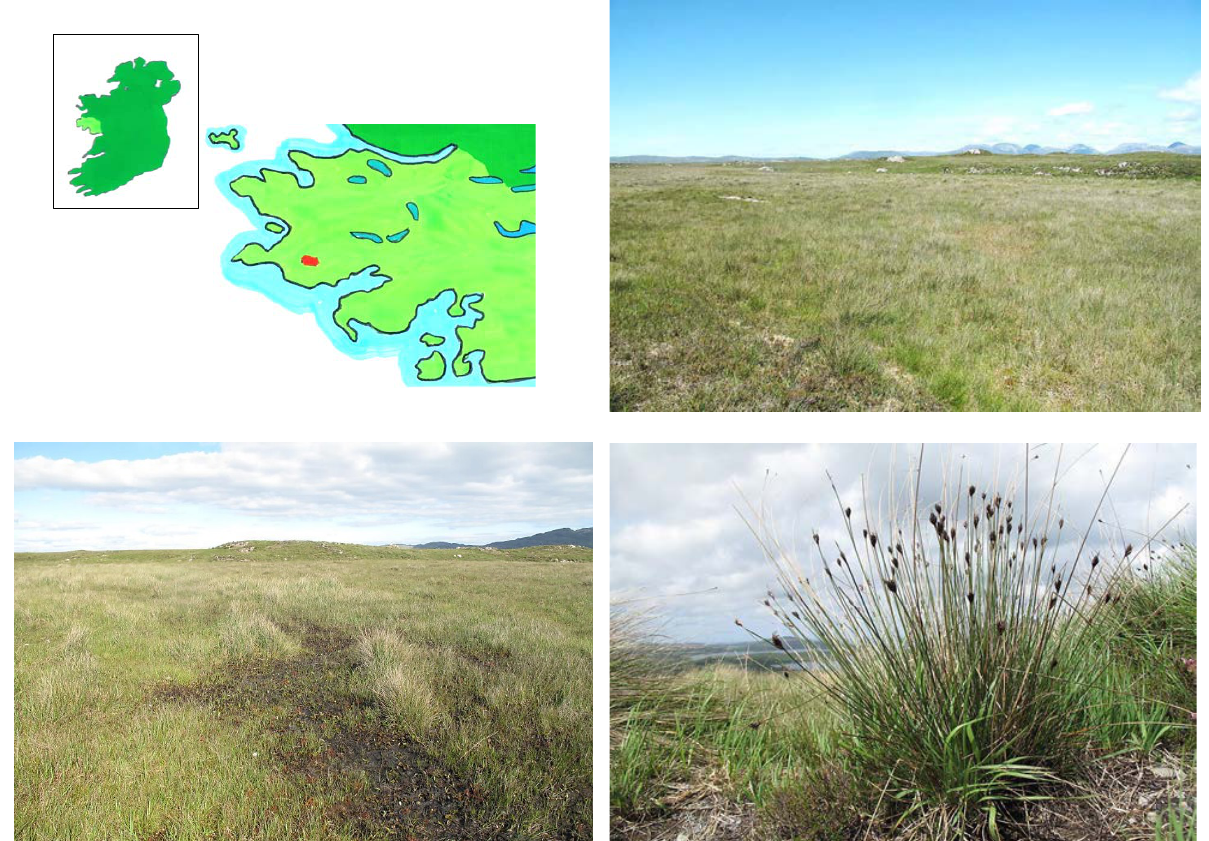
Figure 1. Connemara is situated on the west coast of Ireland (light green, upper left). The position of the research area (Roundstone Bog) is indicated in red. The blanket bogs near Roundstone slope towards the north-west (upper right). Soaks with pioneer vegetation (lower left) and Schoenus nigricans (lower right) are